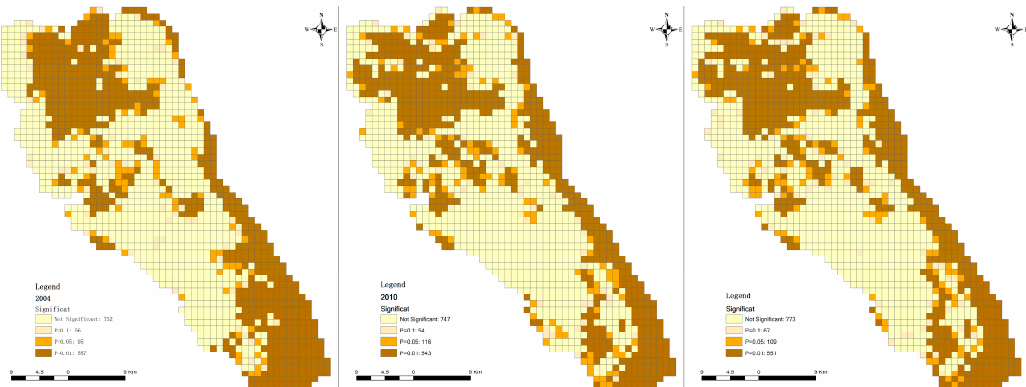
Figure 8. The local spatial autocorrelation analysis significance level of ESD.3.8. Impact of the Urbanization Process on Ecosystem Services.